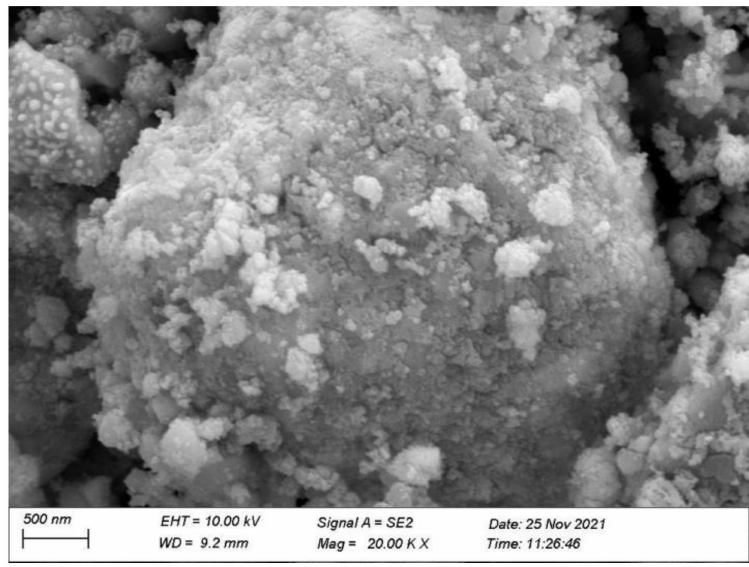
Figure 9. SEM photograph of